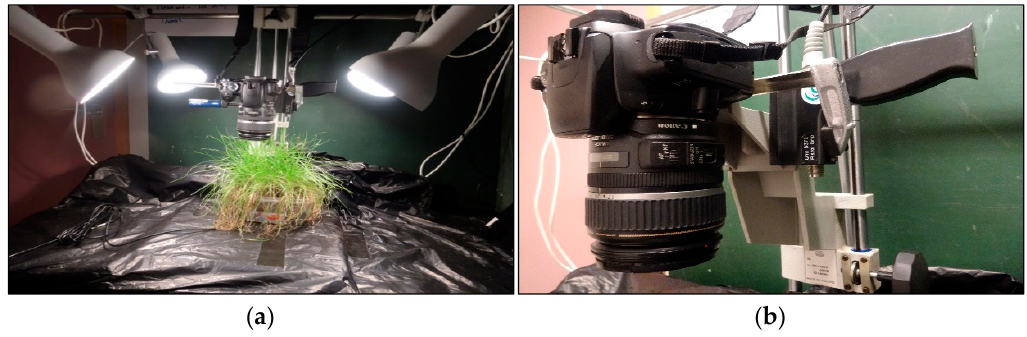
Figure 2. Experimental laboratory setup for canopy and soil reflectance measurement. ( a ) One of the grass sample pots; ( b ) Close-up photo of camera and ASD fiber-optic cable (placed in a pistol grip) mounted on the stand.